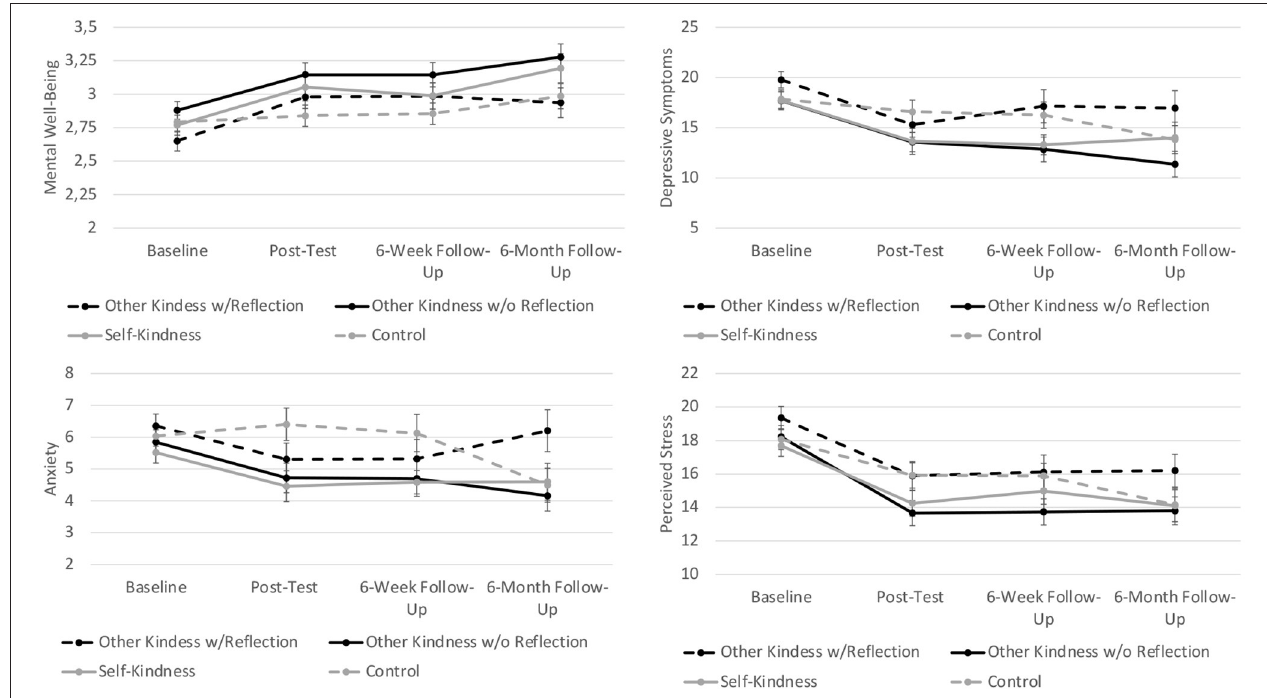
FIGURE 2 | Average changes in well-being and psychological distress outcomes by